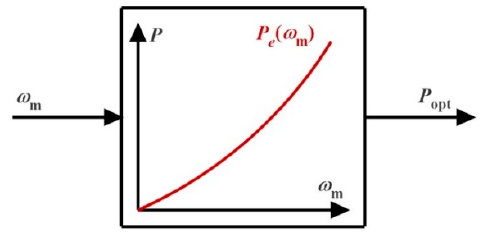
Figure 6. Characteristic power curve-based MPPT.